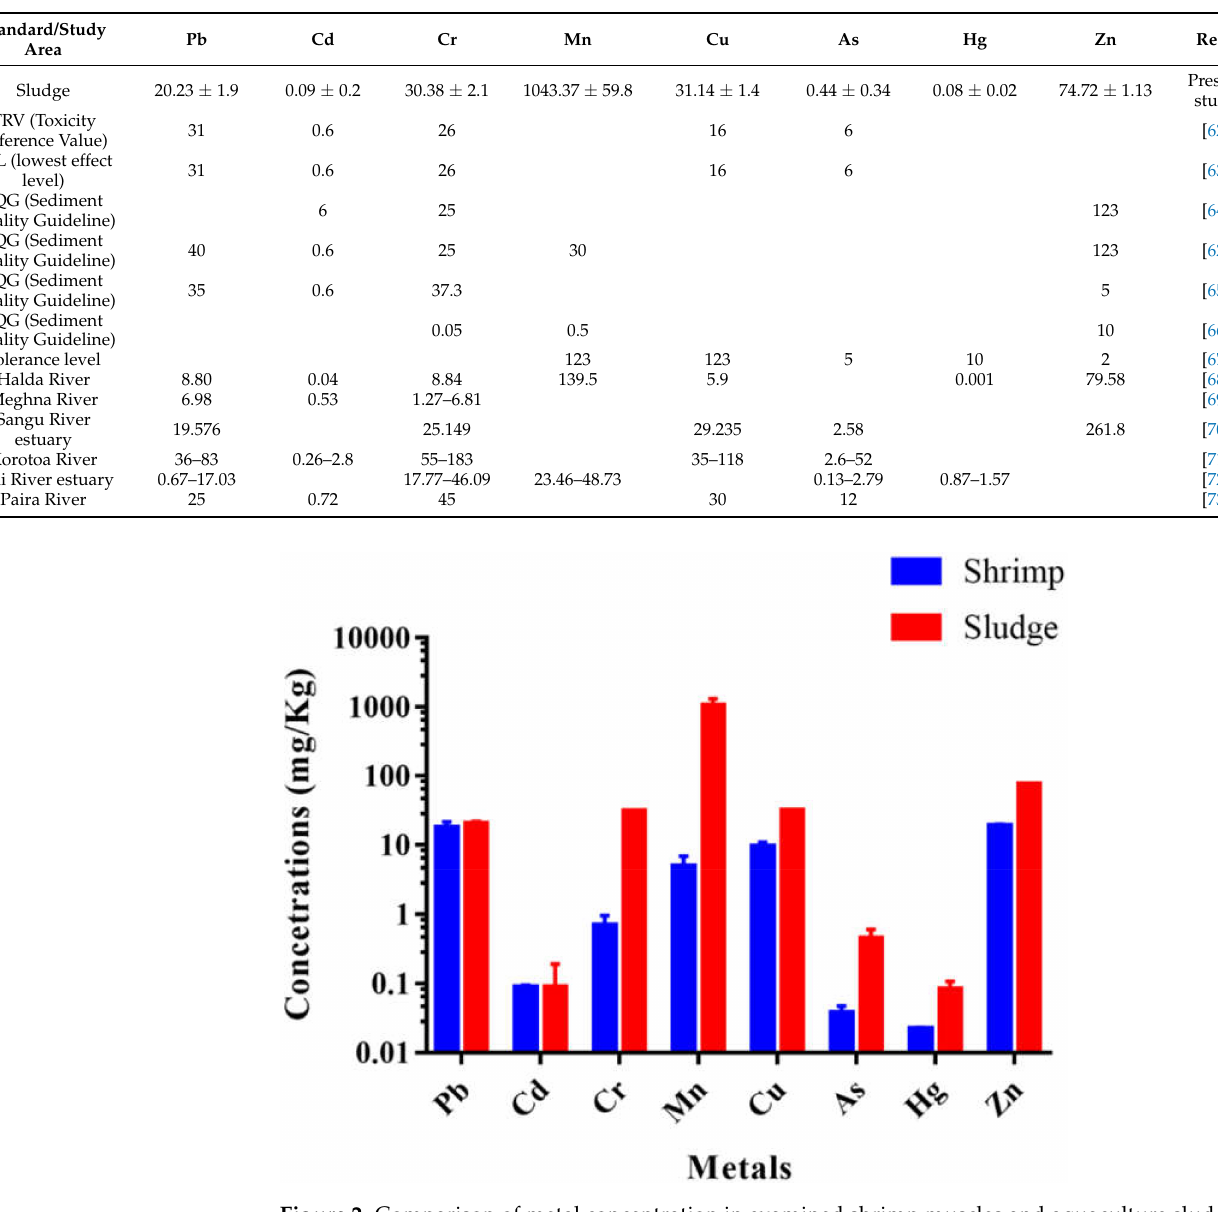
Figure 2. Comparison of metal concentration in examined shrimp muscles and aquaculture sludge in the present